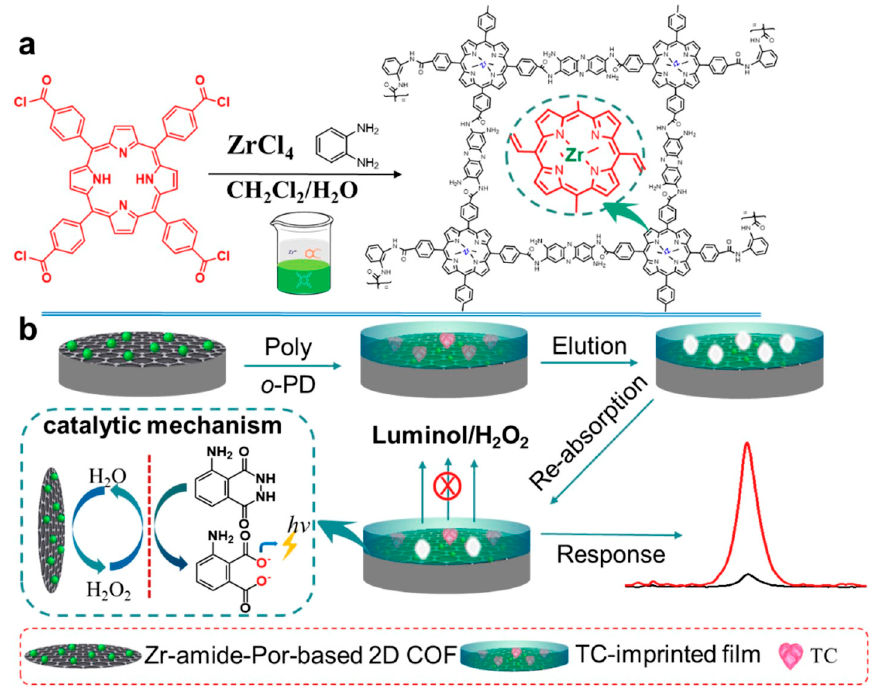
Figure 6. Schematic illustration of the synthesis of a Zr-amide-Por-based 2D COF and its application for the determination of TC from Ref. [82]. Copyright 2019 Elsevier.